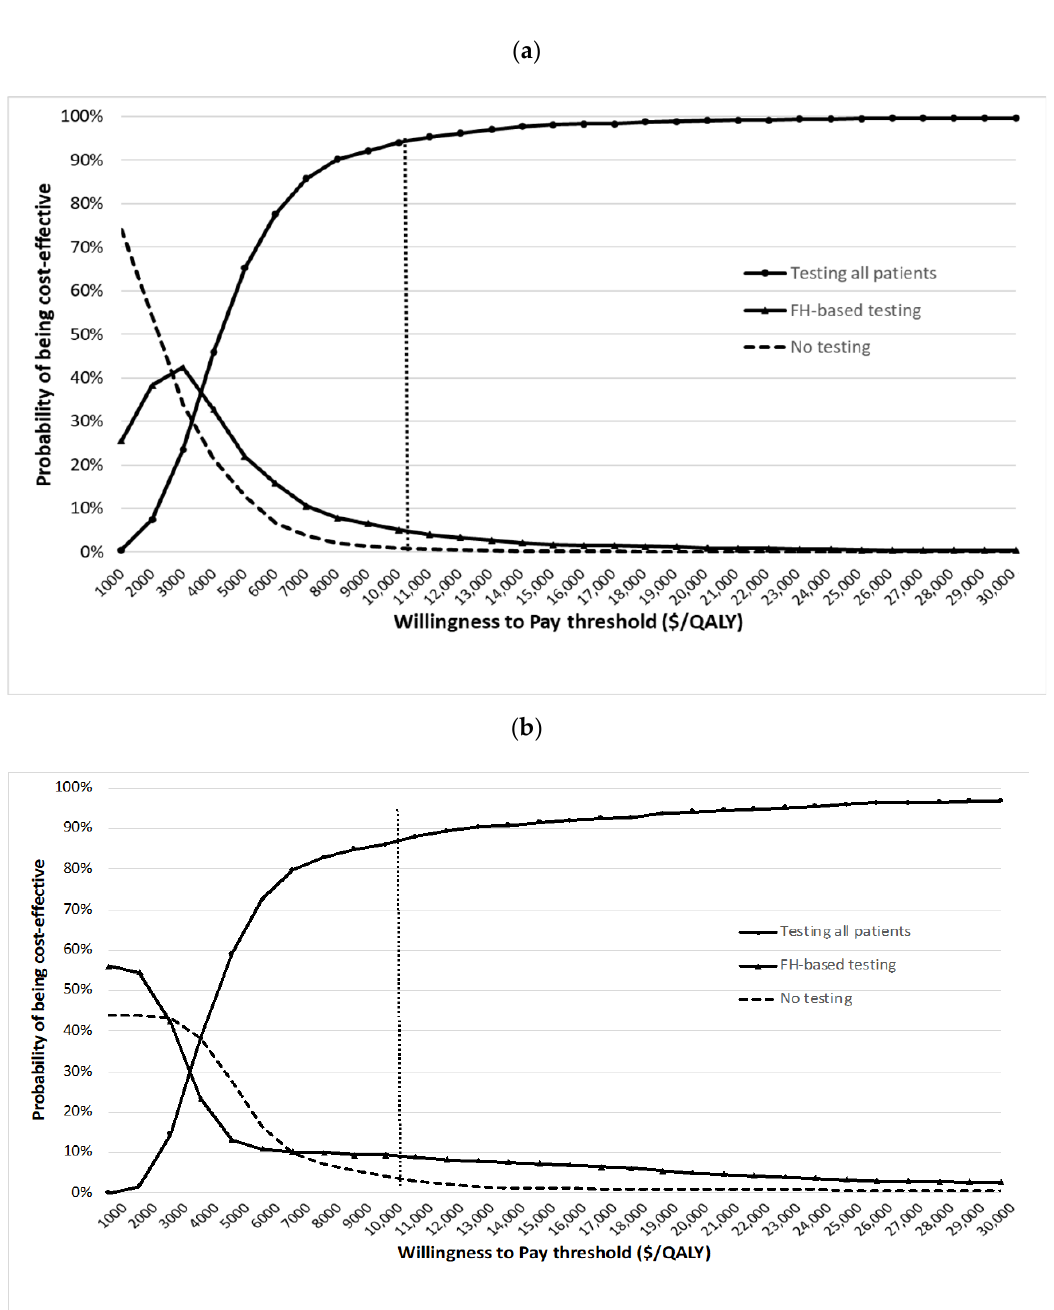
Figure 2. Cost-effectiveness acceptability curves (probabilistic sensitivity analyses): ( a ) cost-effectiveness acceptability curve—societal perspective; ( b ) cost-effectiveness acceptability curve—payer perspective.